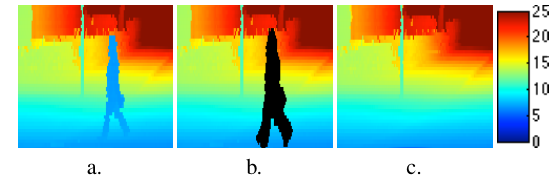
Figure 8. Result of disocclusion on a pedestrian on the KITTI database (Geiger et al., 2013). (a) is the original range image, (b) the segmented pedestrian (dark), (c) the final disocclusion. Depth scale is given in meters.